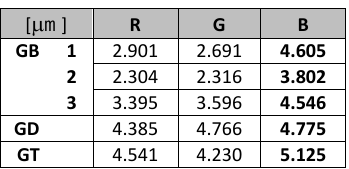
Table 9. Comparison of the decentring distortion correction in 1.9 mm radial distance, combined adjustment. All units in  m. The largest correction value for each dataset is highlighted.